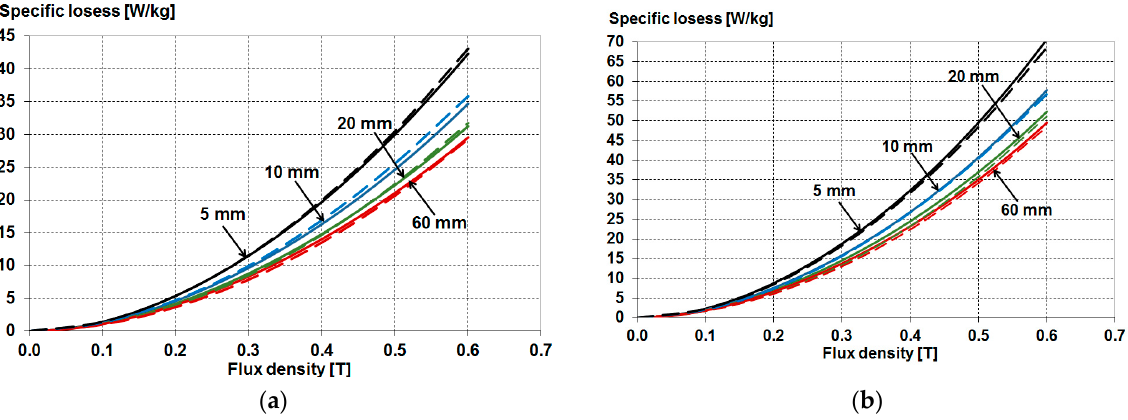
Figure 17. Measured and approximated loss characteristics of the M 270-35A sheet for different widths of the sheet samples, at the frequency of 1000 Hz ( a ), 1400 Hz ( b ); (measured—solid line, estimated—dashed line).